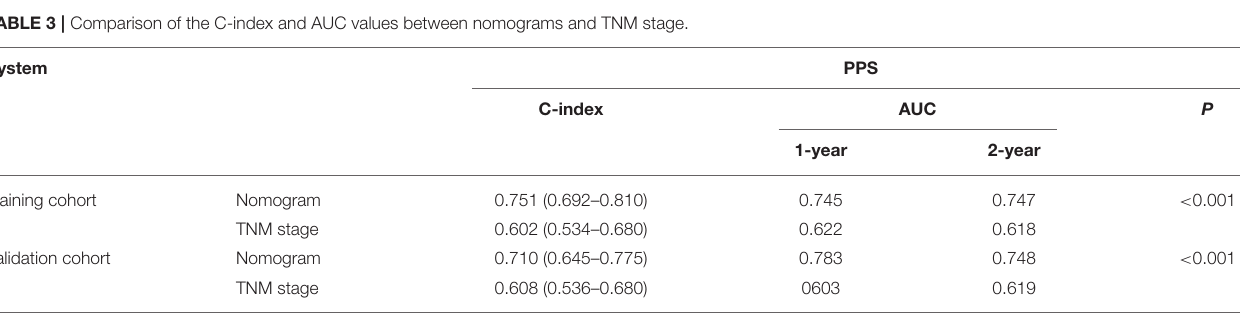
TABLE 3 | Comparison of the C-index and AUC values between nomograms and TNM